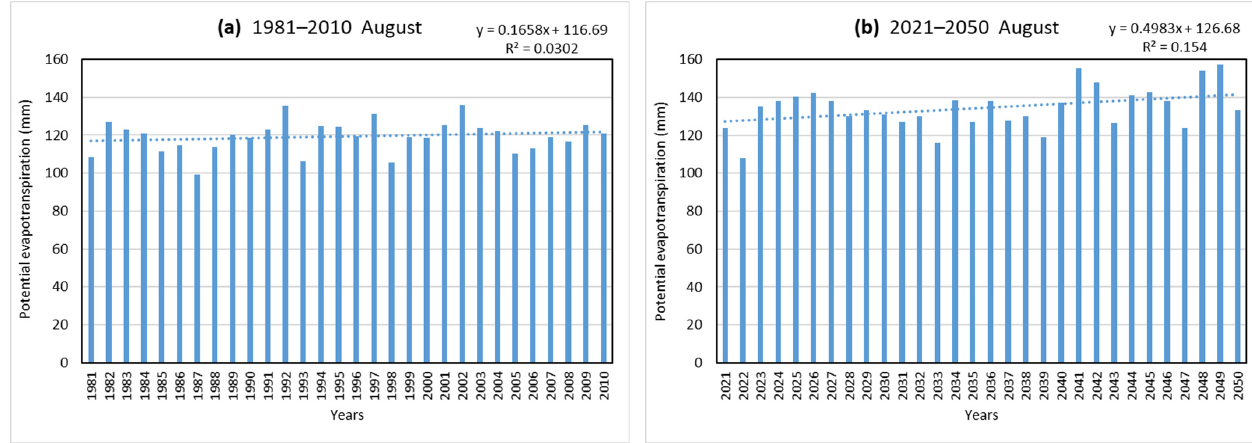
Figure 5. Time trend of sweet cherries' potential evapotranspiration in August in the reference ( a ) and forecast period ( b ). The trend line is marked with a dashed line.